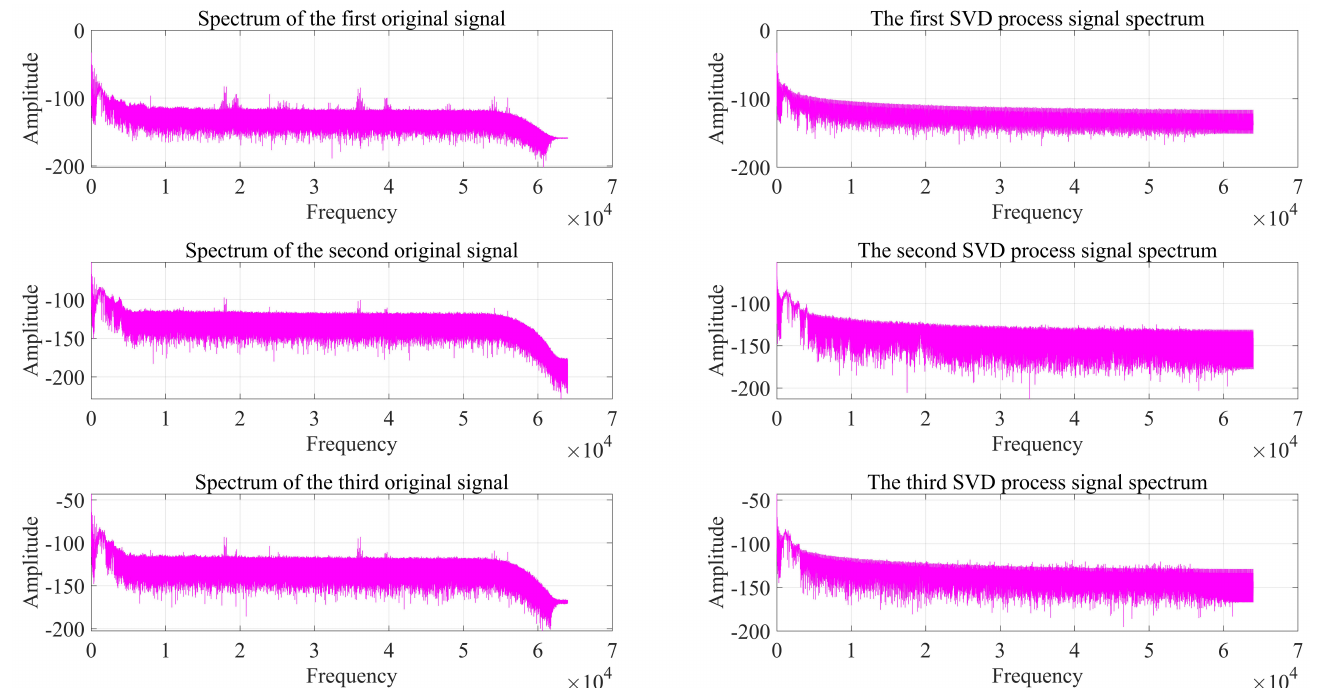
Figure 18. Comparison of the original spectrum of the three-channel signal and the spectrum after noise